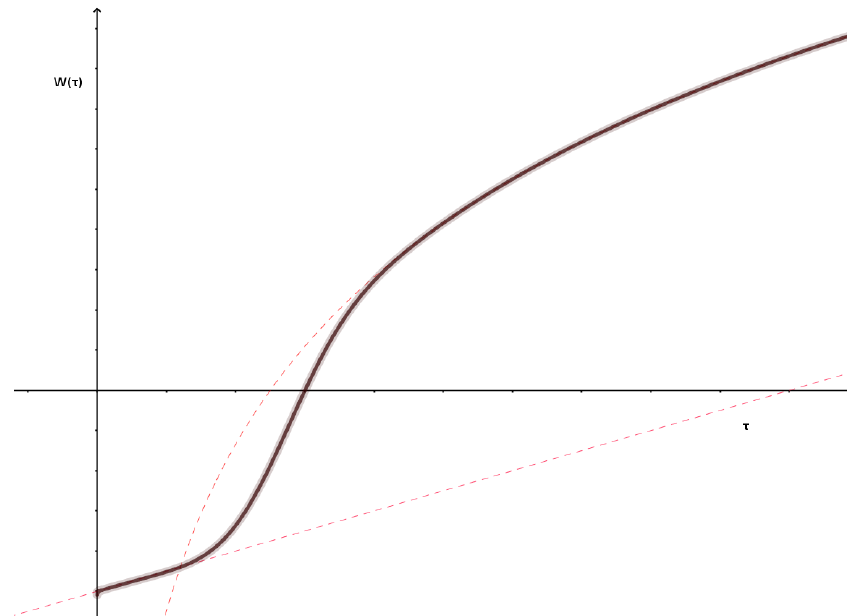
Figure 3. S-Shaped utility function of